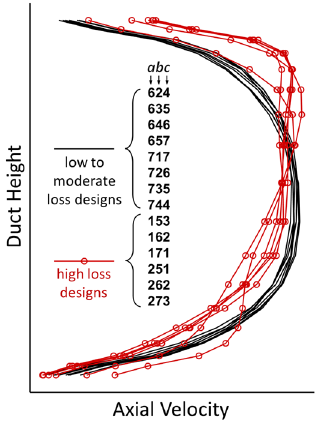
Figure 19. Relative variation of the axial velocity profile at diffuser 1 exit in DoE 1.